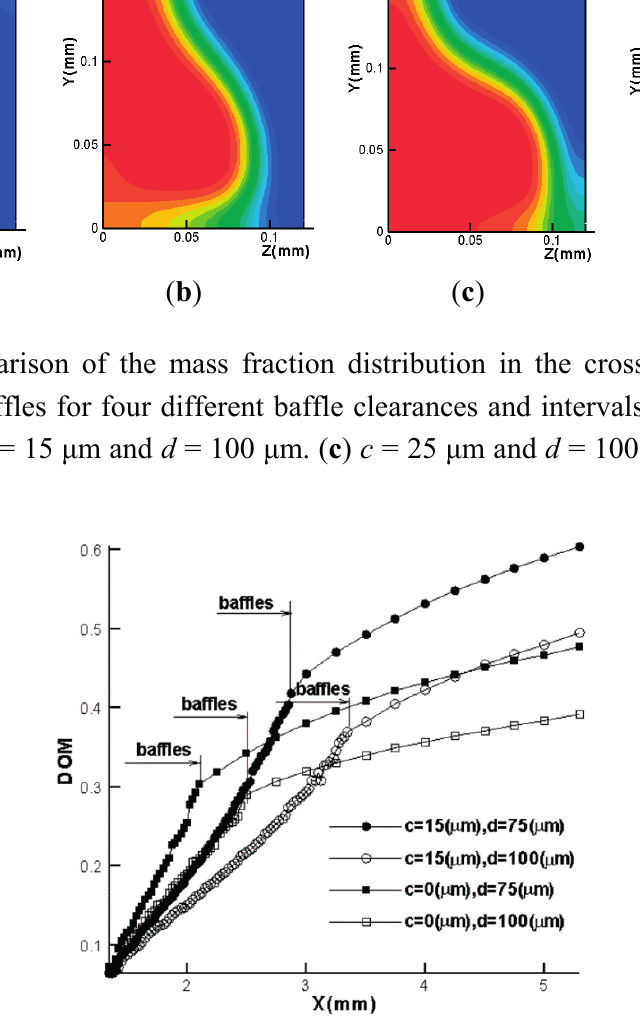
Figure 14. Comparison of DOM evolution along the outlet